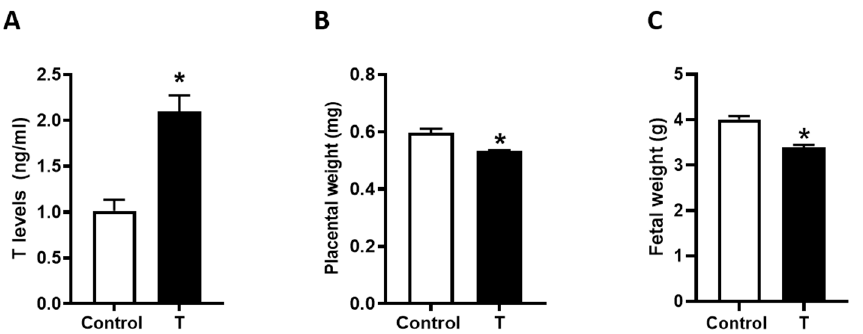
Figure 1. Plasma T levels and placental and fetal weights in control and T-treated pregnant rats. Pregnant rats were treated with vehicle (sesame oil) or T propionate from gestation day 15 to 19 and euthanized on day 20. ( A ) Plasma T levels were quantified using ELISA. ( B ) Placental and ( C ) Fetal weights were measured. Data presented as mean ± SEM of 6 rats in each group. * p < 0.05 vs. control.